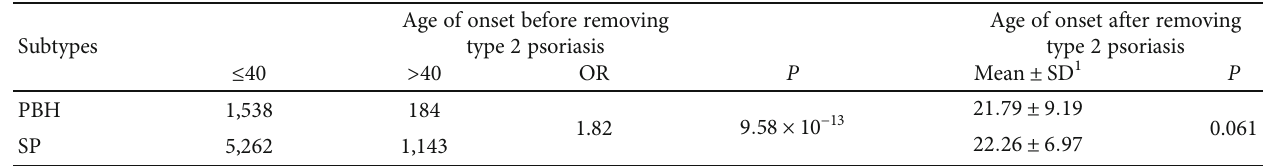
Table 1: Description of study samples of patients with